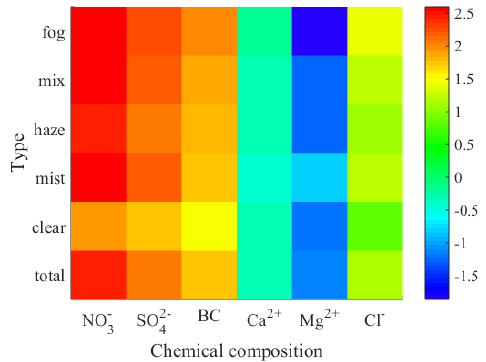
Figure 9. Logarithmic distribution of extinction contribution of each component in different processes in the IMPROVE model.